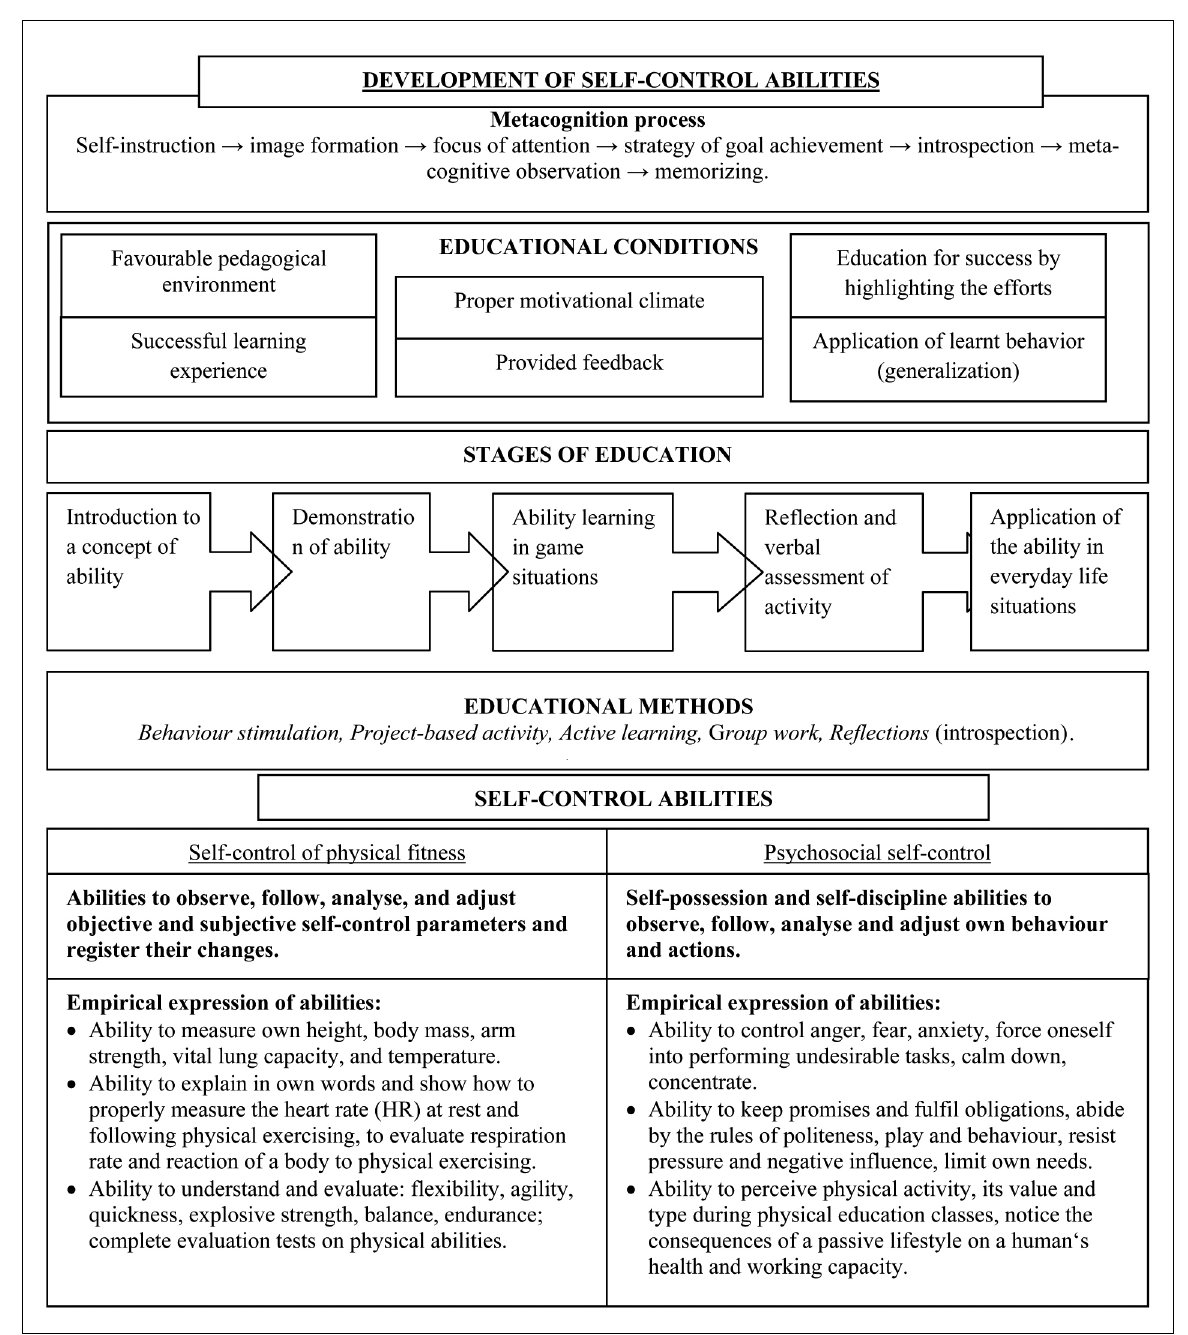
Figure 1. Theoretical model on development of self-control